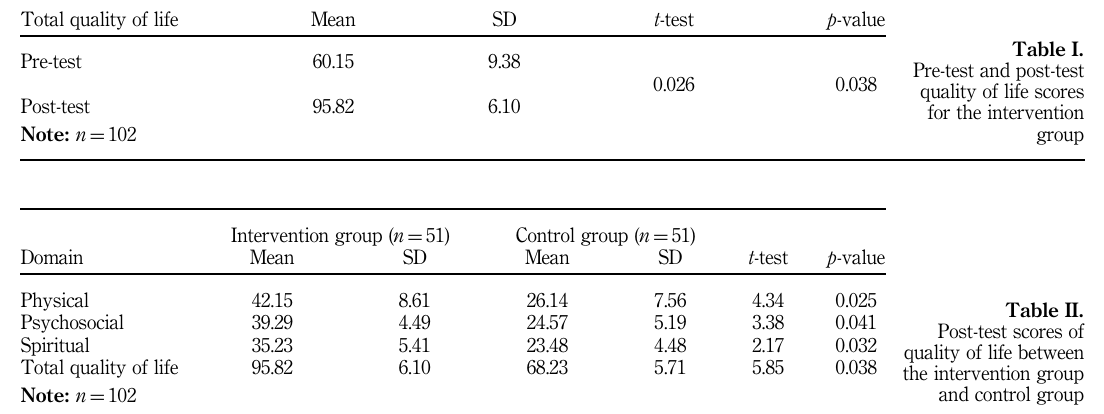
Table I. Pre-test and